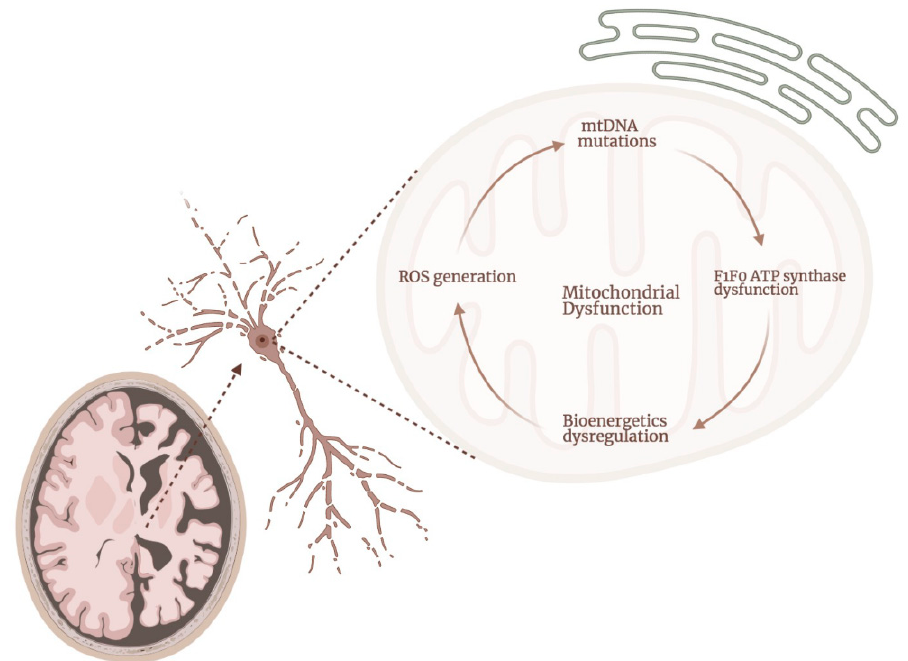
Figure 2. Mitochondrial dysfunction is present at different levels in mitochondria, in a deleterious cycle which increases the damage to the organelle and the cells in AD. Dysregulation of the mitochondrial ATP synthase is present in neurons and other cellular populations in the brains of AD patients. This dysregulation will further contribute towards bioenergetics dysfunction and the consequent increased production of ROS. That rise in the levels of ROS is one of the main causes underlying the damage present in AD in the mtDNA, which will further affect the expression and the activity of the ATP synthase, starting the deleterious cycle again.